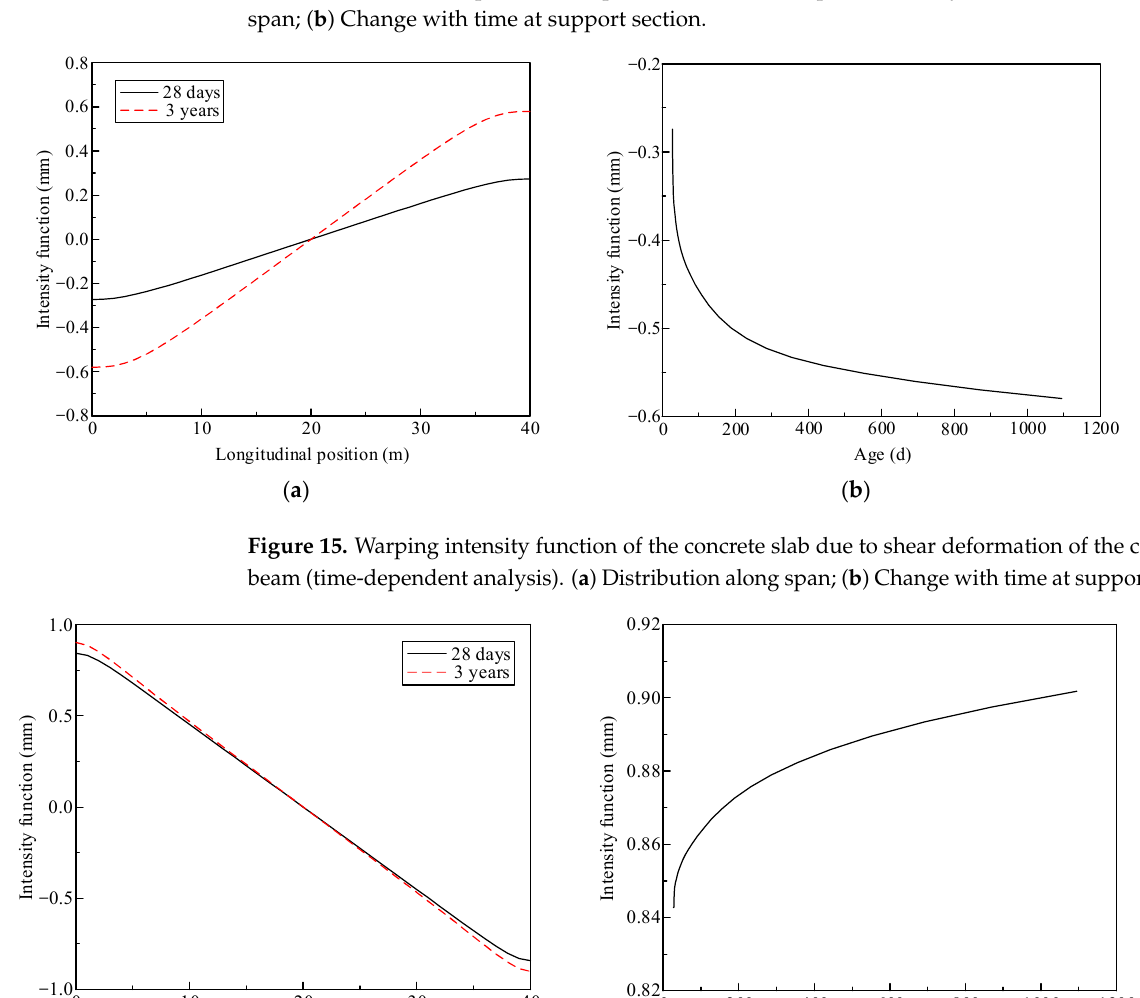
Figure 15. Warping intensity function of the concrete slab due to shear deformation of the compo- site beam (time-dependent analysis). ( a ) Distribution along span; ( b ) Change with time at support section.